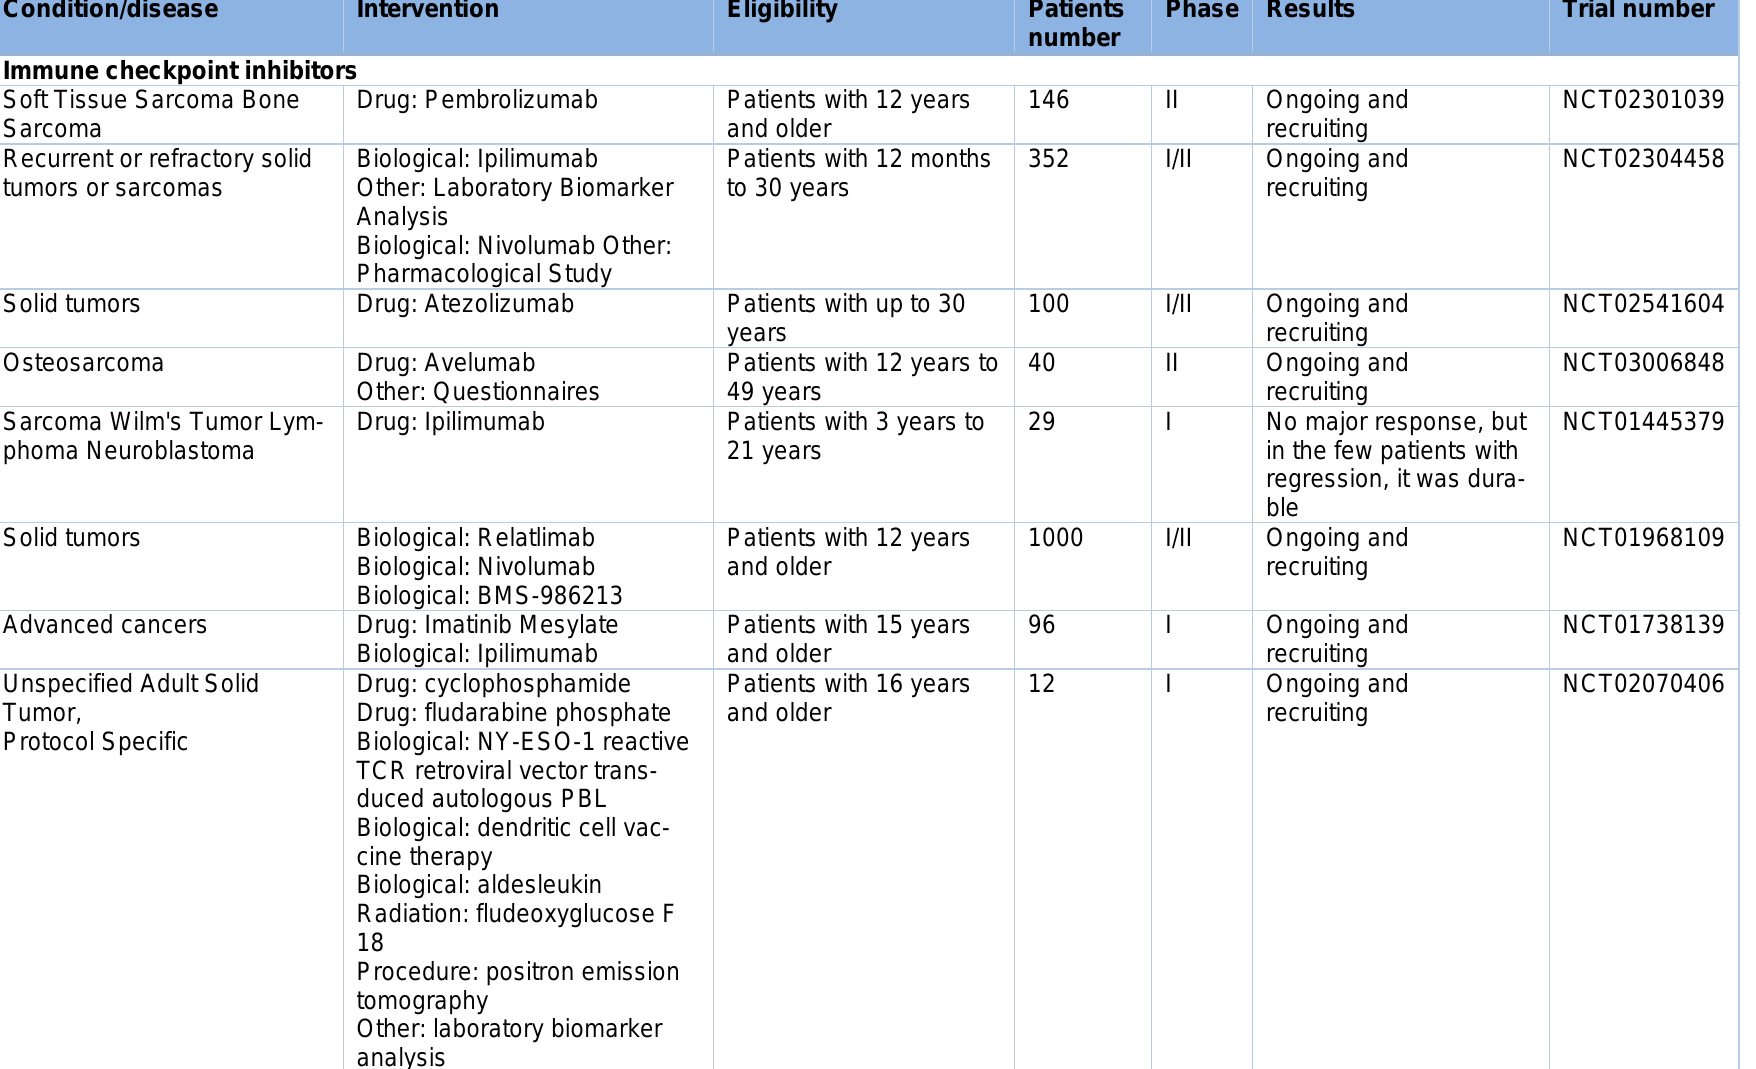
Table 1: Clinical trials for osteosarcoma by checkpoint inhibitor